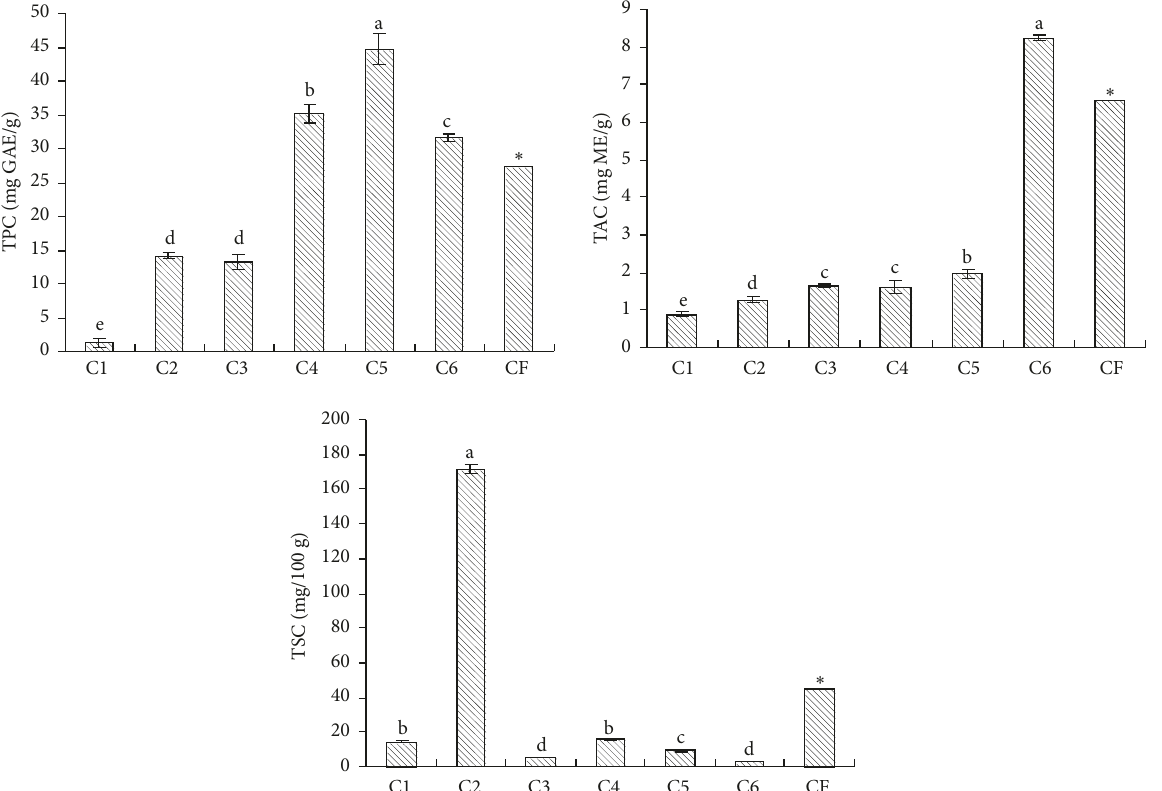
Figure 4: Contents of secondary metabolites of constituents separated from the chloroform fraction. The values are means ± standard deviations of triplicate analyses. Columns labeled with different letters are significantly different (𝑃 < 0.01) by Duncan test. ∗ Values of CF are from Figure